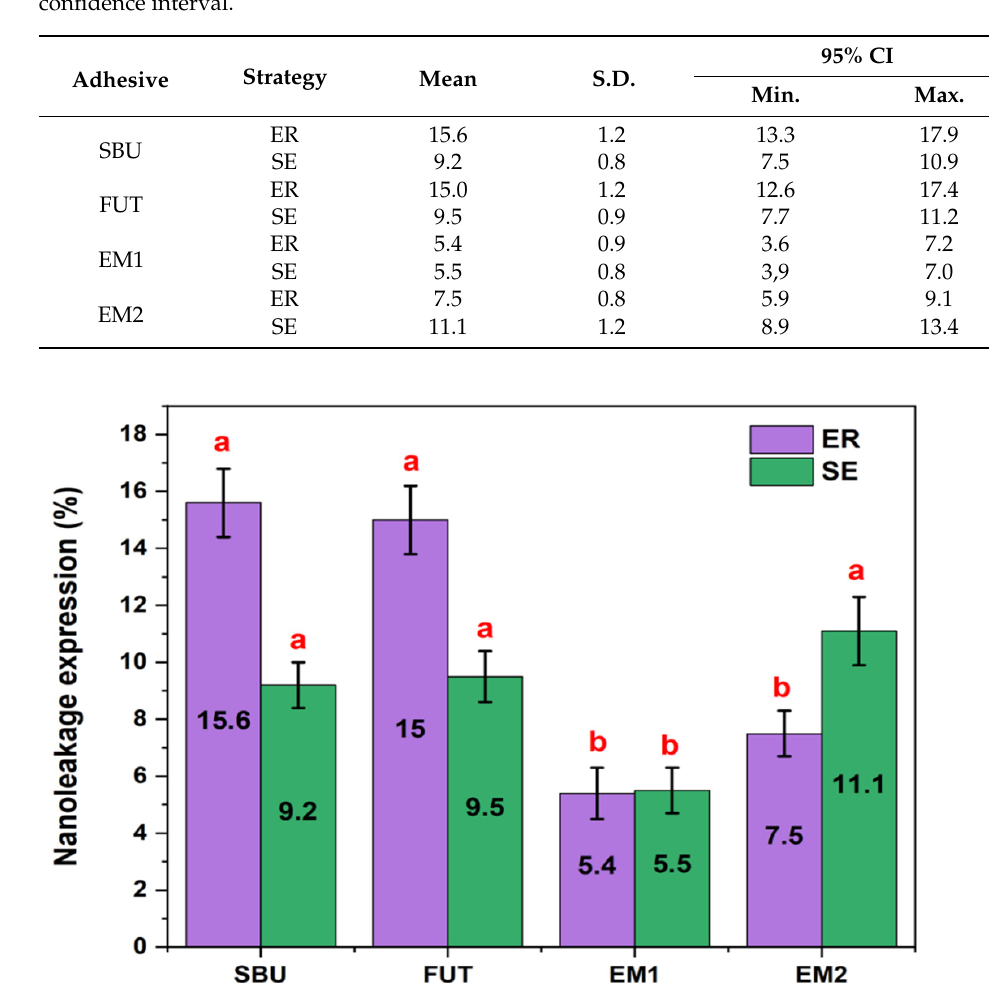
Figure 3. Graphical representation of nanoleakage, by mean percentage scores, in all experimental groups under study, depending on the adhesive strategy used. Different letters (a,b) refer to statistically significant differences among adhesives and protocols.